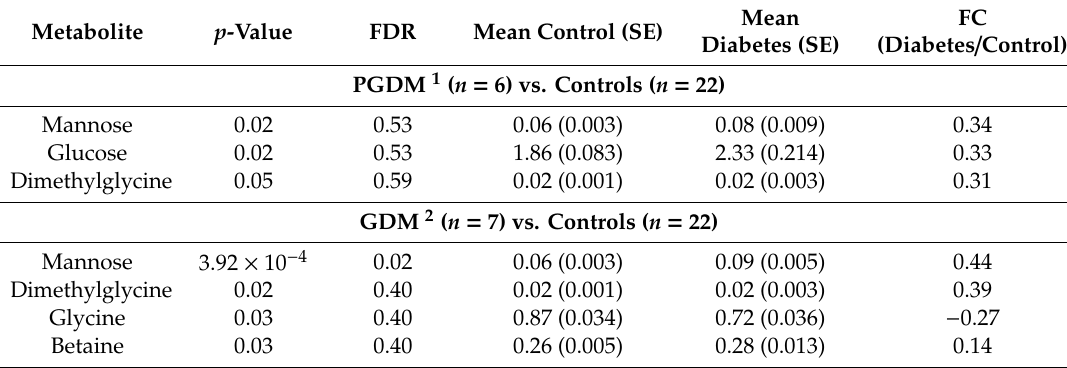
Table 7. Metabolites Significantly Altered in Cord Blood in PGDM or